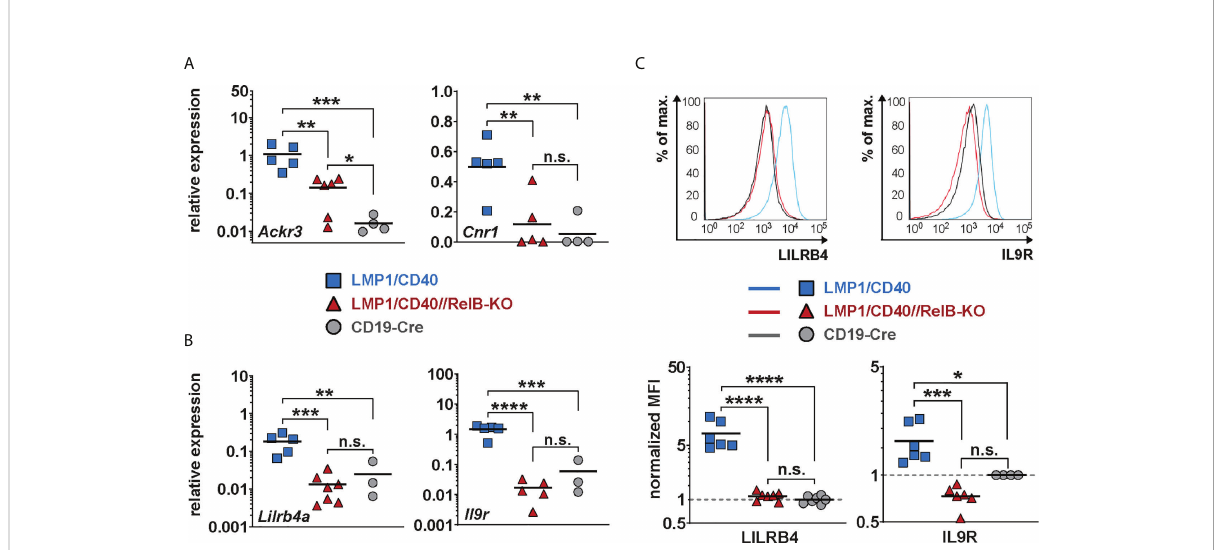
FIGURE 6 Lilrb4a and Il9r are differentially expressed at the RNA and protein level in RelB-pro fi cient in comparison to RelB-de fi cient LMP1/CD40 expressing B cells: (A, B) The amount of mRNA of the indicated genes was determined in splenic B cells from LMP1/CD40 (blue), LMP1/CD40// RelB-KO (red) and control (CD19-Cre, grey) mice by qRT-PCR. Due to their log normal distribution, expression values of Ackr3 , Lilrb4a and Il-9R were logarithmized before statistical analysis by an ordinary one-way ANOVA, Tukey´s multiple comparisons test. Ackr3 N ≥ 4; Cnr1 N ≥ 4; Lilrb4a N ≥ 3; IL-9R N ≥ 3 independent RNA preparations. (C) The histogram overlays show the surface expression of LILRB4 and IL-9R in the indicated genotypes. The histograms are pre-gated on live lymphocytes and CD19 + cells. The graphs give the summary of MFIs from independent experiments. LILRB4 N ≥ 6; IL-9R N ≥ 4. Ordinary one-way ANOVA with Tukey ’ s multiple comparison was performed. (A – C) P-values in * P<0.05, ** P<0.01, *** P<0.001, **** P<0.0001. Symbols represent values from individual mice, and the lines indicate means. n.s. = not signi fi